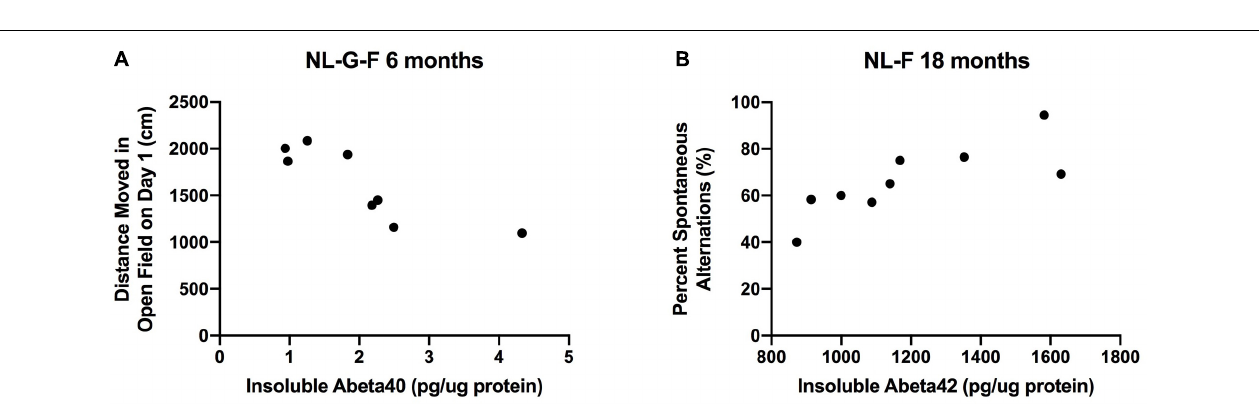
FIGURE 14 | (A) Insoluble A β 42 levels were higher in NL-F than NL-G-F mice. * p = 0.0116. (B) Insoluble A β 40 levels were not different between the two lines. (C) The insoluble A β 42/40 ratio was higher in NL-F than NL-G-F mice. * p = 0.0171. (D) Soluble A β 42 levels were higher in NL-F than NL-G-F mice. **** p < 0.0001. (E) There was a trend toward higher soluble A β 40 levels in NL-F than NL-G-F mice. # p = 0.0822. (F) There was no line difference in the soluble A β 42/40 ratio.